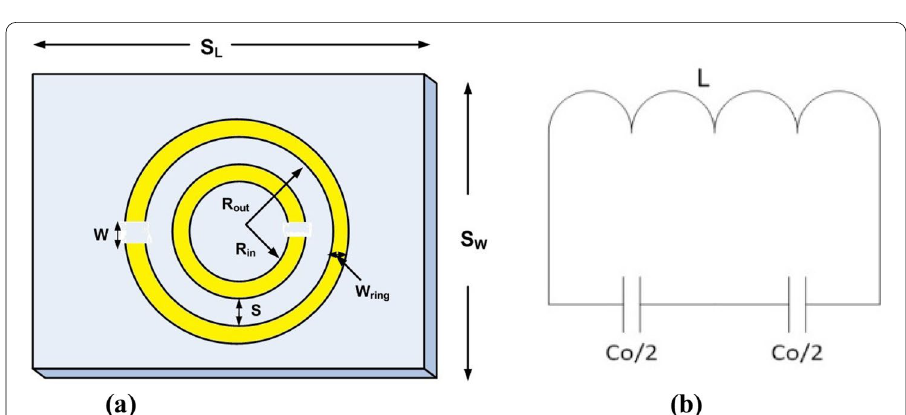
Fig. 5 a Geometric structure of unit cell of SRR, Rout mm, S w 10 mm, b Equivalent circuit of unit cell of =